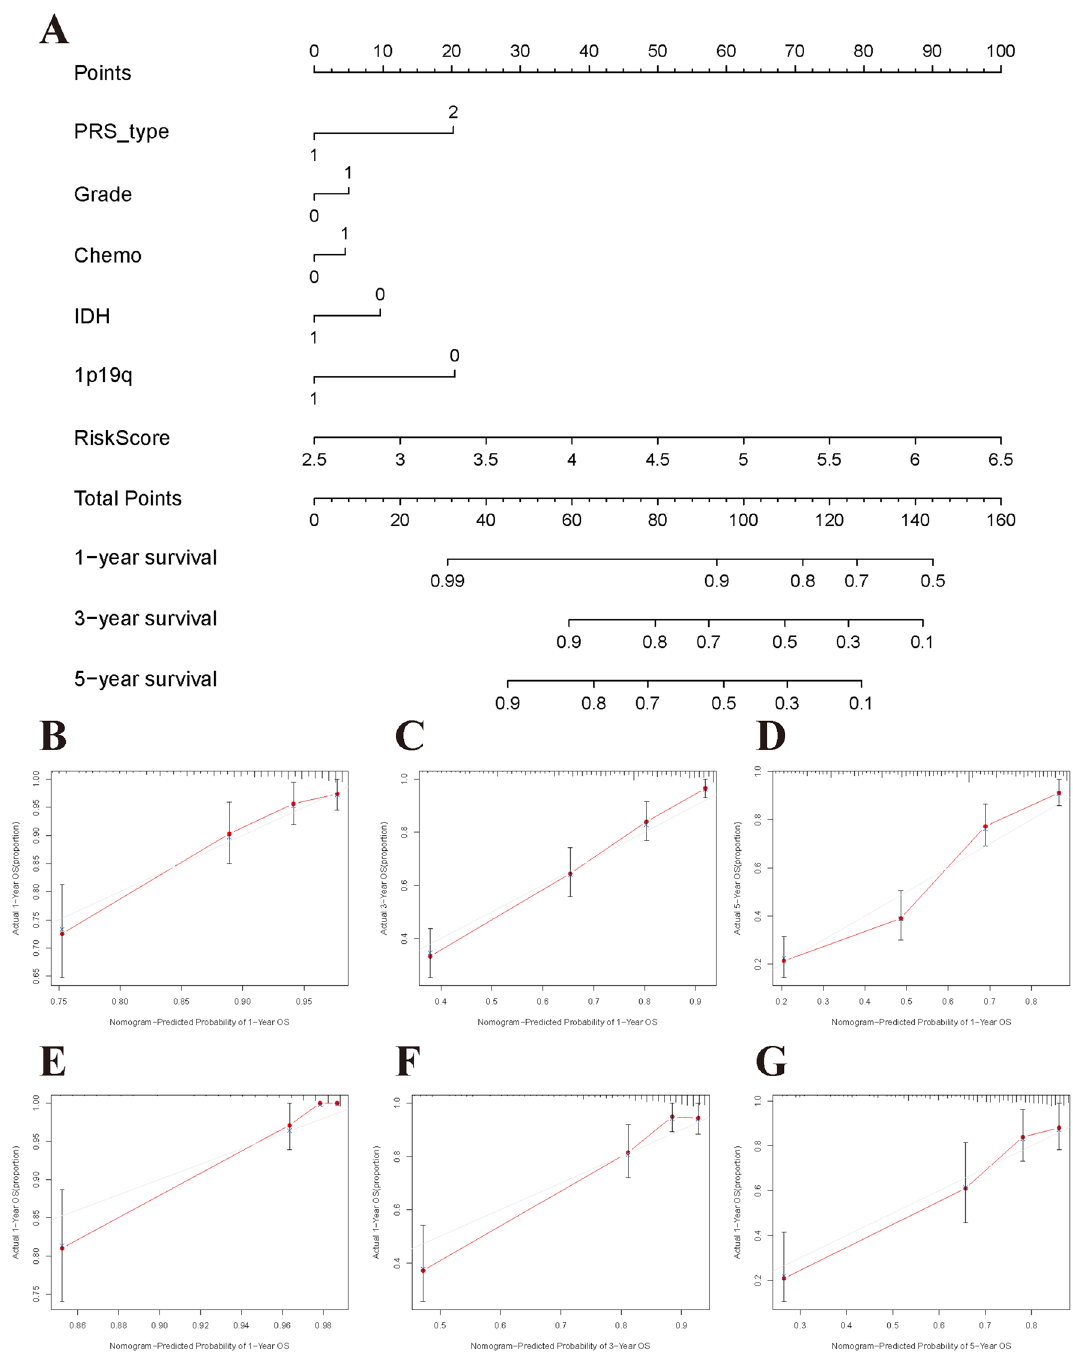
Figure 5. Clinical application and assessment of nomogram model based on pyroptosis genes signature. ( A ) Nomogram plot using CGGA dataset. ( B – D ) The 1-year, 3-year, and 5-year calibration curves in the CGGA cohort. ( E – G ) The 1-year, 3-year, and 5-year calibration curves in the TCGA